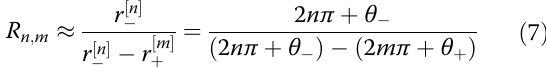
Fig. 3 Zak phase reconstruction from the absorption spectra. The experimental data of the absorption spectra for a the Semenoff insulator superradiance lattices with Ω 1 ; 2 ¼ 120 MHz and Δ c ¼ 174, 232, and 298 MHz from top to bottom, and b the SSH superradiance lattices with Δ c ¼ 0, Ω 1 ¼ 118 MHz, and Ω 1 = Ω 2 ¼ 6 : 52, 4 : 25, and 2 : 15 from top to bottom. We use the marked extrema ϵ ± ( Δ n ; m ) in absorption peaks and dips to locate the band centers (anti-crossings). The measured R n ; m (points) compared with the normalized ratio of WCs (dashed lines) for c the Semenoff insulator and d the SSH superradiance lattices, from which we reconstruct the Zak phases θ ± in e and f . Error bars are obtained from four independent data sets (see WSLs and more absorption spectra in Supplementary Note